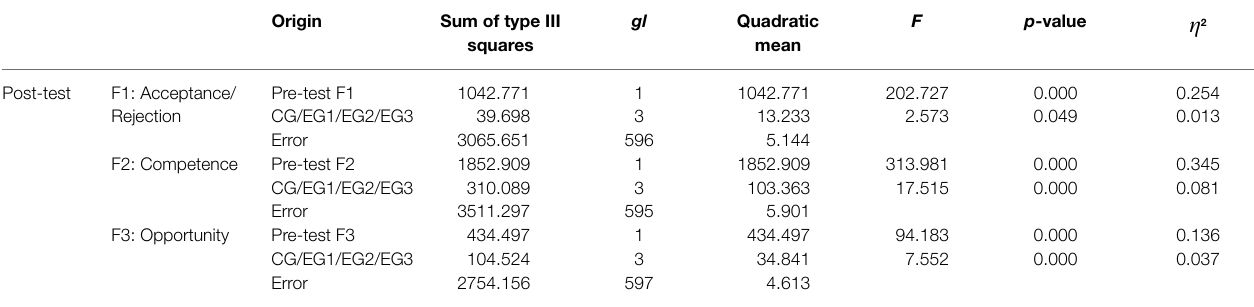
TABLE 5 | Inter-subject effects test